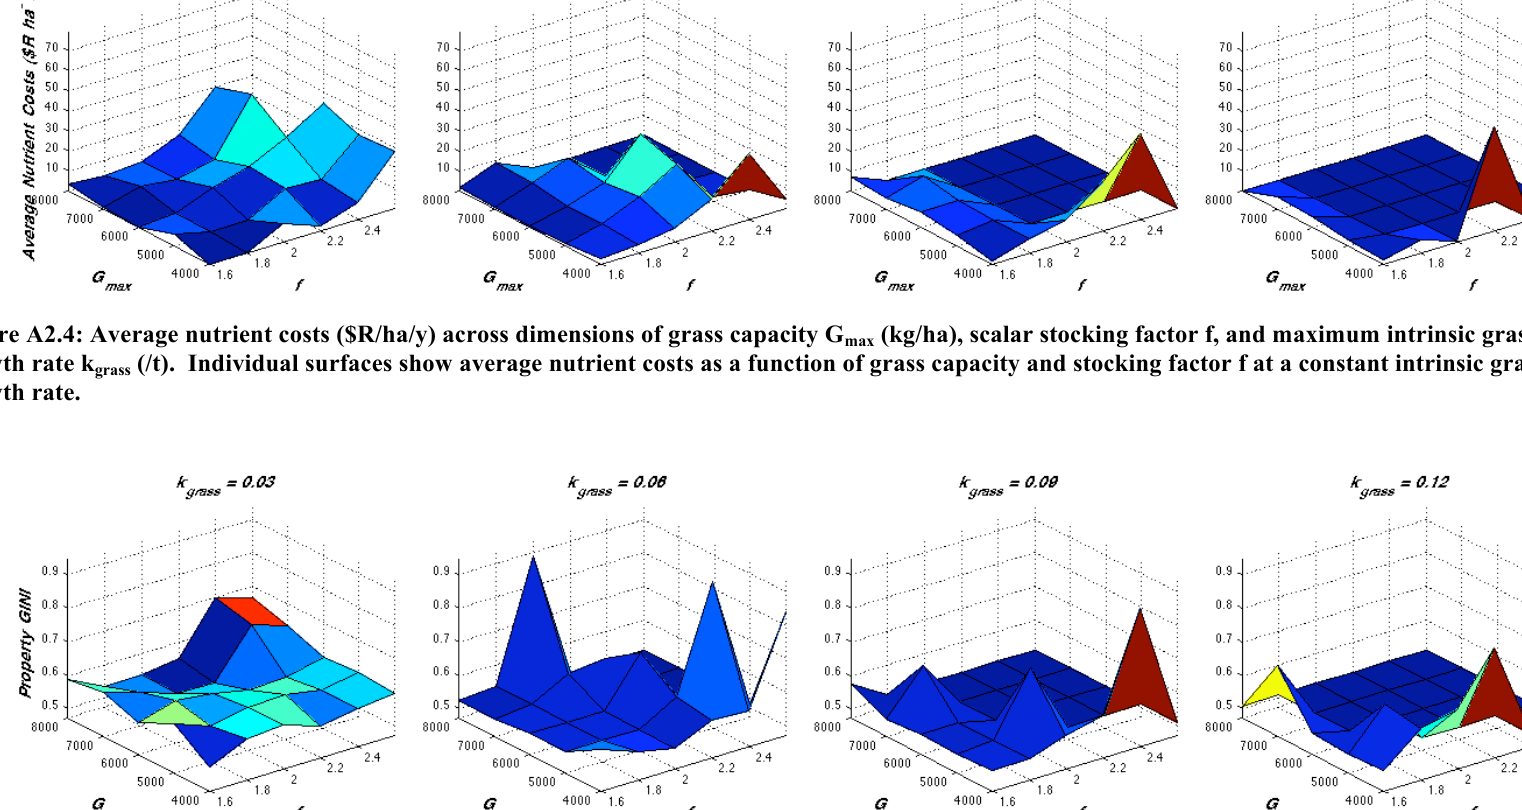
(kg/ha), scalar stocking factor f, and maximum intrinsic grass growth rate k max